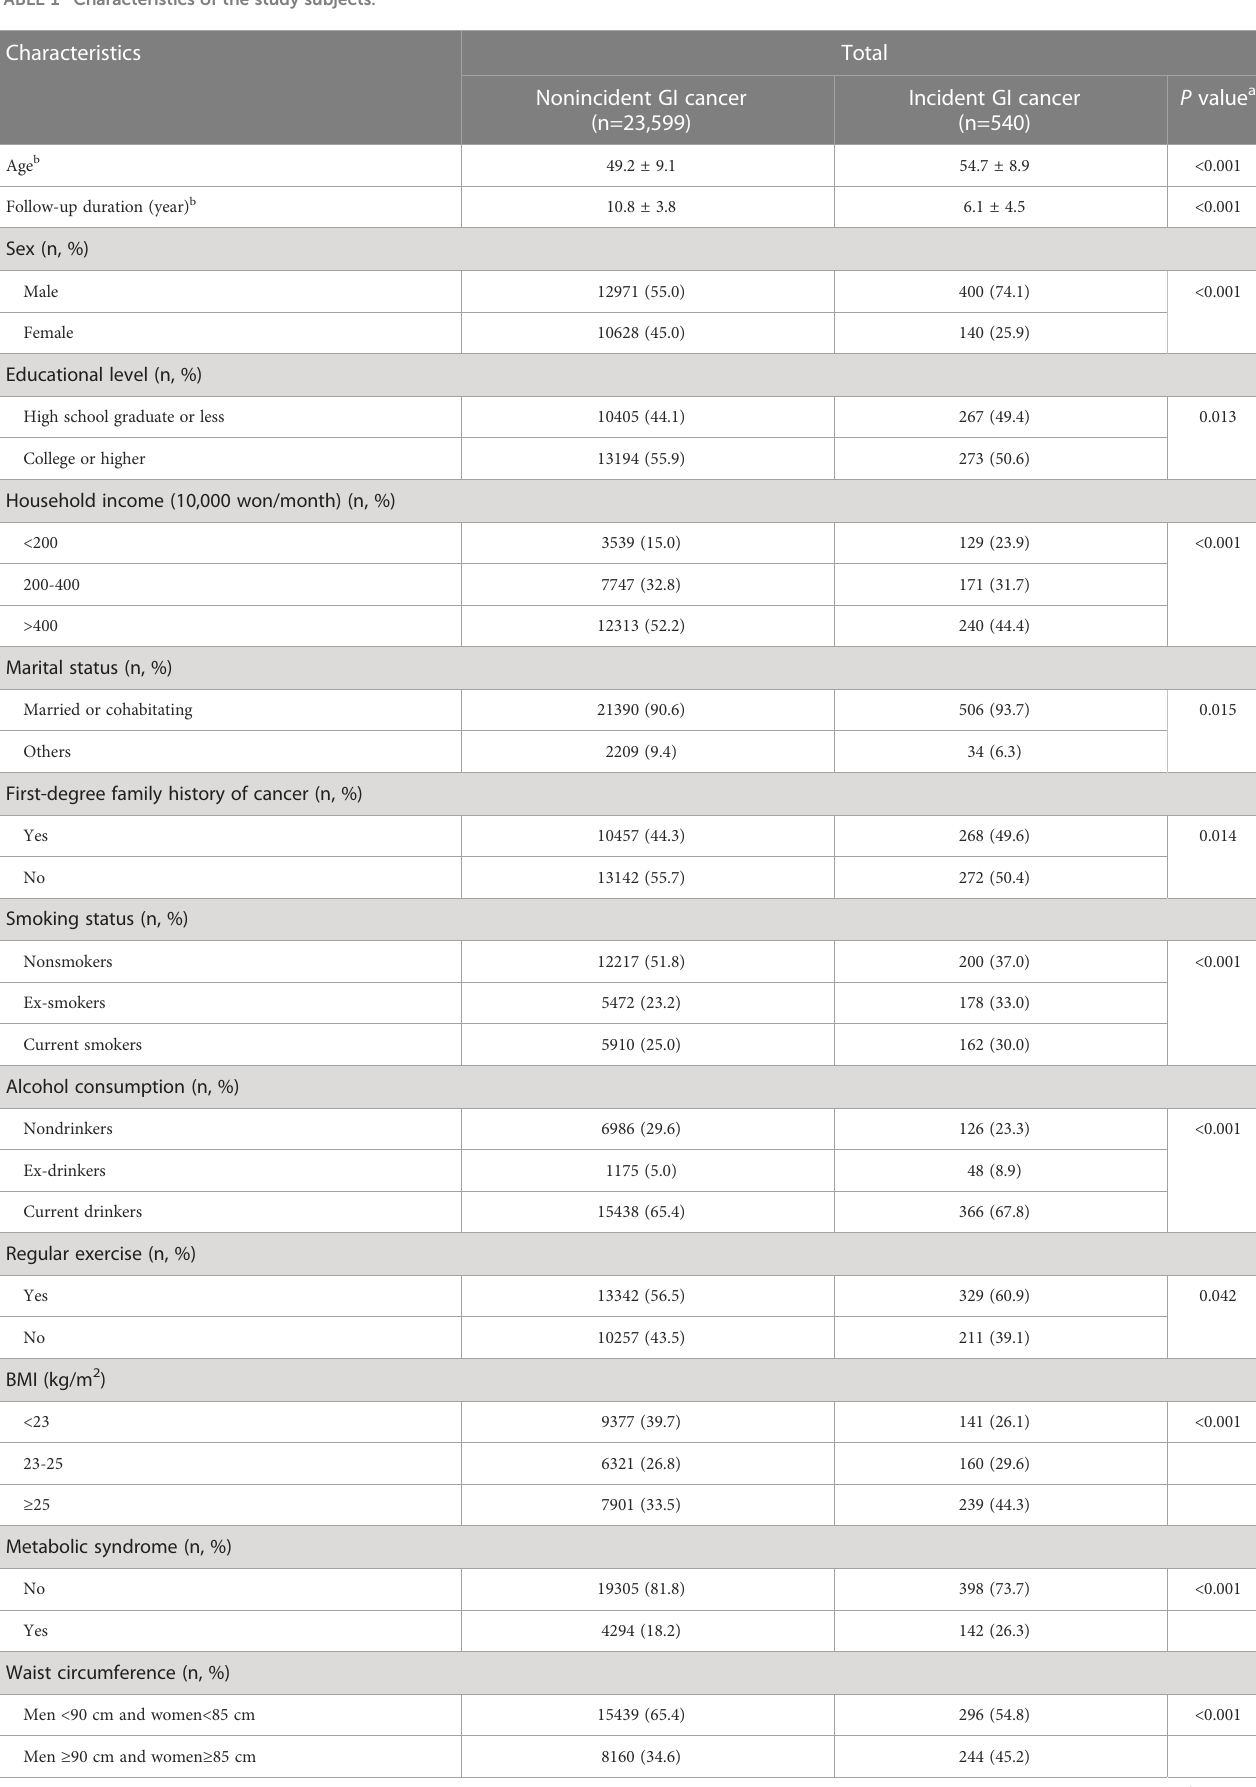
TABLE 1 Characteristics of the study